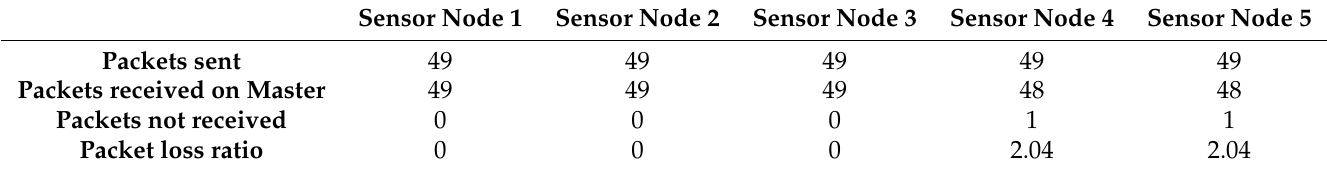
Table 9. LoRa Radio Communication Static Test 2. Communication in Opposite